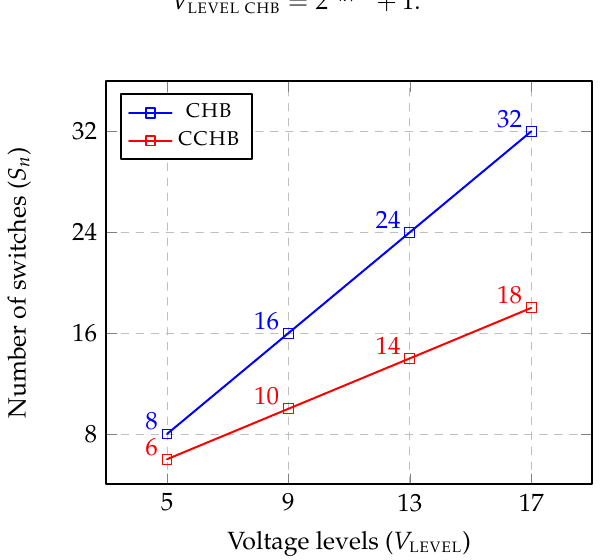
Figure 10. Number of required switches for proposed CCHB with CHB